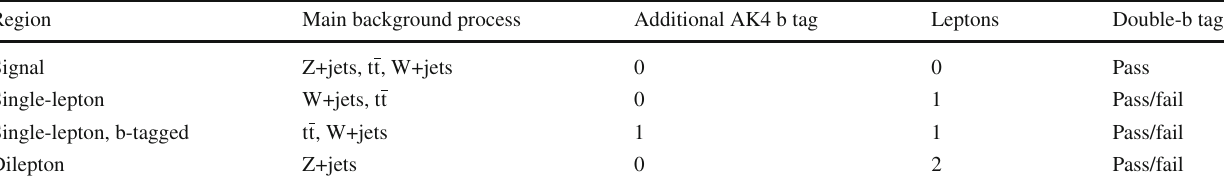
Table 1 Event selectioncriteriadefining the signal andcontrol regions. These criteria are applied in addition to the preselection common to all regions, as described in the text. The presence of a b-tagged AK4 jet